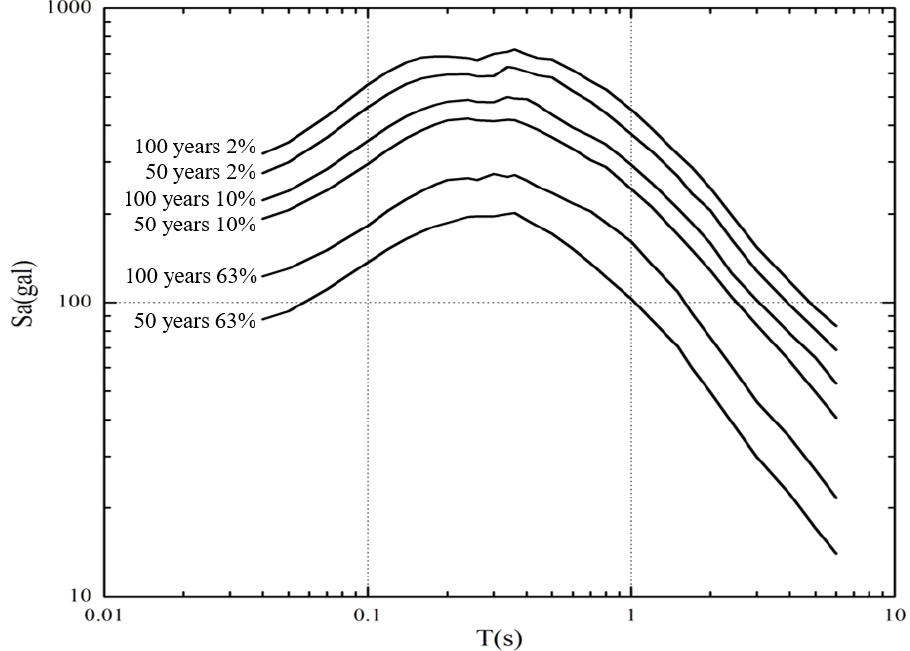
Figure 4. Response spectrum curve of the bedrock horizontal acceleration at the engineering site of Najin Lhasa.